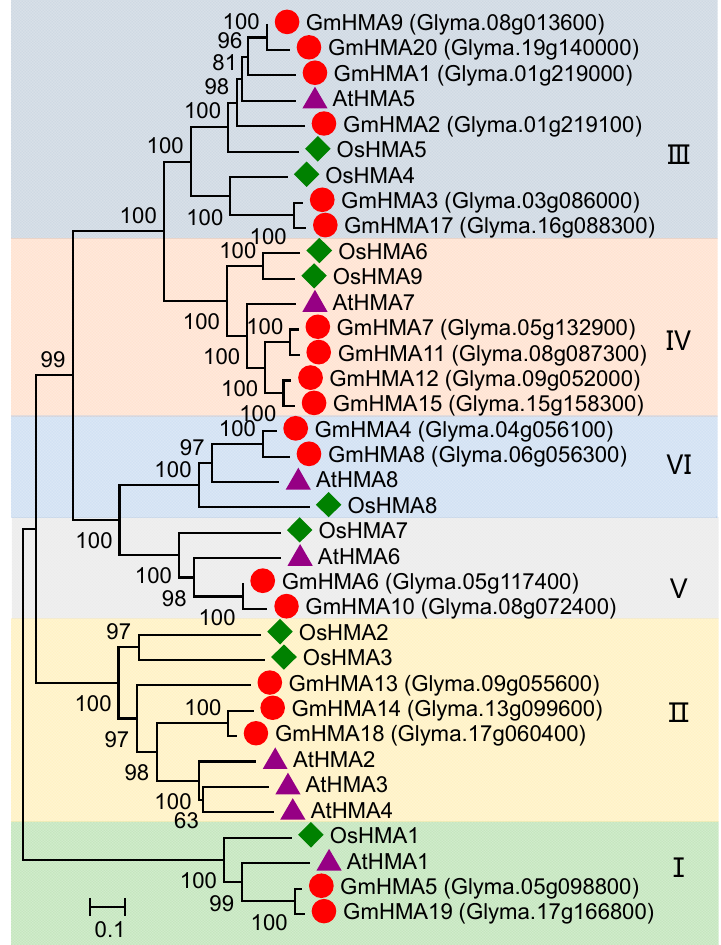
Figure 3. Phylogenetic tree of P 1B family proteins from soybean ( Glycine max ), rice ( Oryza sativa ), and Arabidopsis thaliana : the full-length amino acid sequences were aligned by ClustalW. The neighbor-joining phylogenetic tree was constructed by MEGA6 with 1000 bootstrap replications. GmHMAs are denoted by red circles, AtHMAs are denoted by purple triangles, and OsHMAs are denoted by green diamonds. The locus name of a soybean gene is shown in brackets. Roman numerals designate the subfamilies.